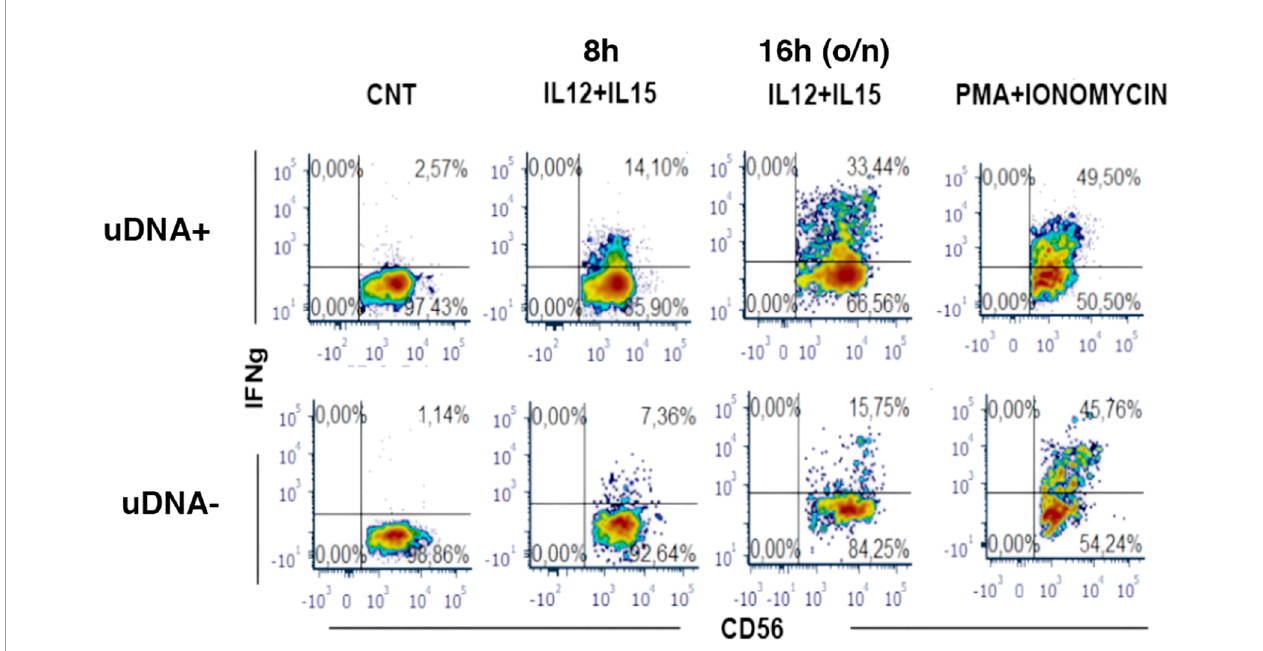
FIGURE 5 | IFN- g production is conserved in peripheral blood Natural Killer cells from cART-treated and plasma HIV-RNA suppressed patients with presence of uDNA. Flow cytometric analysis of IFN- g production by CD56+ NK cells upon 8h- and 16h-stimulation in vitro with IL-12+IL-15. Medium alone as negative control (CNT) or maximal stimulus as positive control (PMA+IONO) are also shown. Upper row: uDNA positive patient (uDNA +), lower row: uDNA negative patient (uDNA